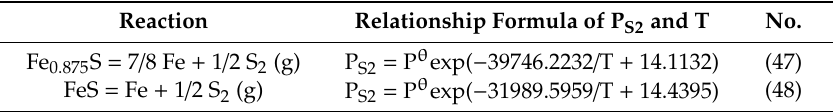
Table 2. Pyrolysis of FeS and Fe 0.875 S and the corresponding relationship between P S2 and T. Reaction Relationship Formula of P S2 and